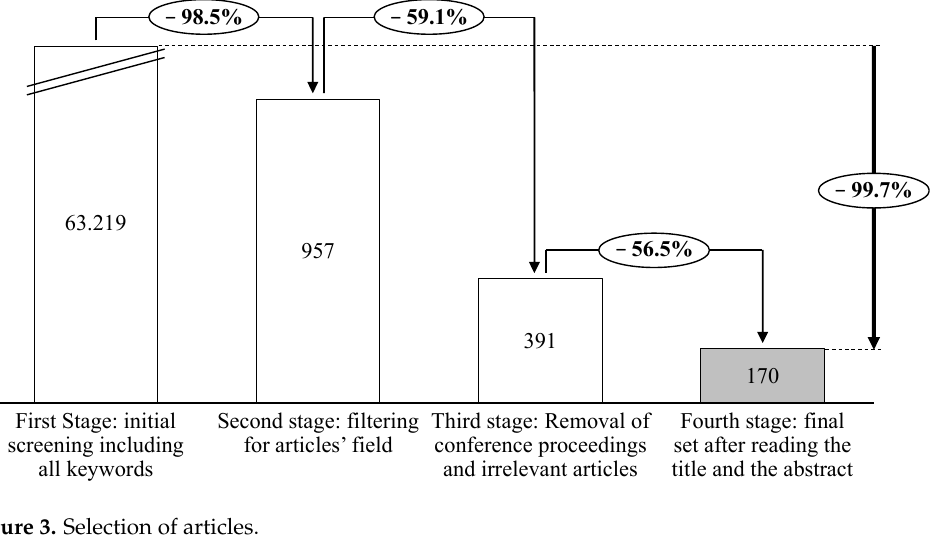
Figure 3. Selection of articles.